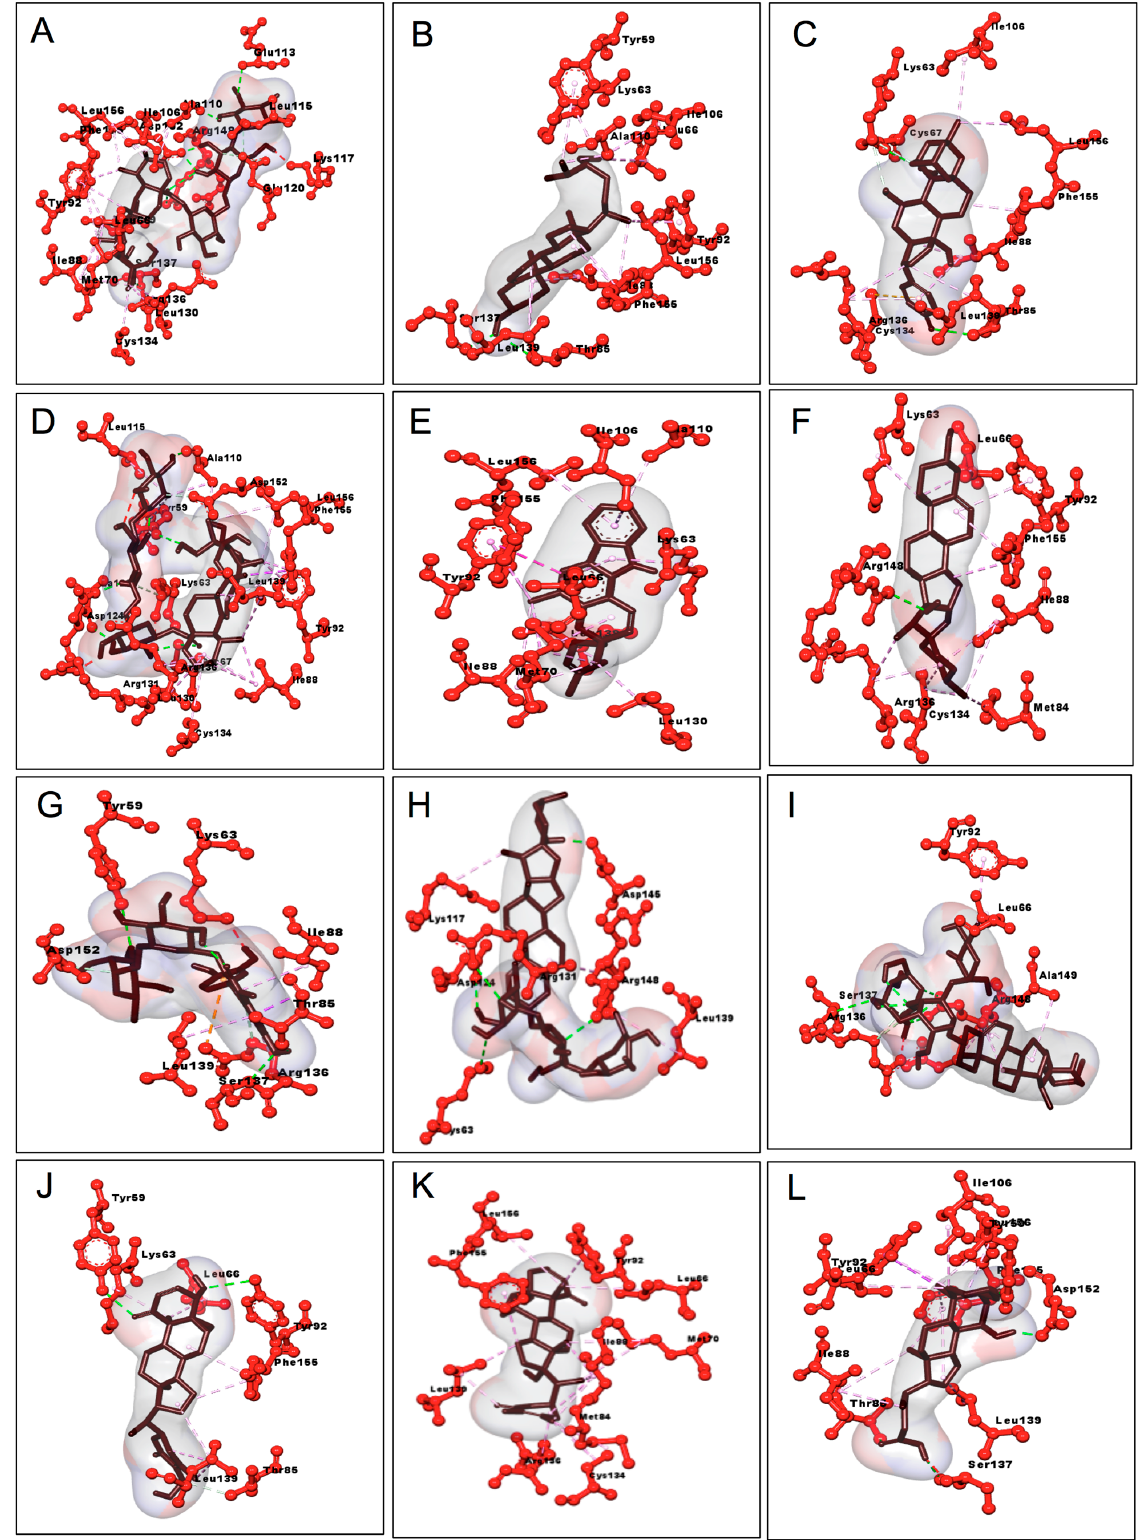
Figure 4. Three-dimensional interactions of active phytocompounds and standard drugs in complex with RamR protein of Salmonella Typhimurium : ( A ) asiaticoside, ( B ) beta-sitosterol, ( C ) bryophyllin A, ( D ) madecassoside, ( E ) mahanimbine, ( F ) pennogenin, ( G ) rutin, ( H ) solamargine, ( I ) solasonine, ( J ) withaferin A, ( K ) withanone, and ( L ) chenodeoxycholic acid.